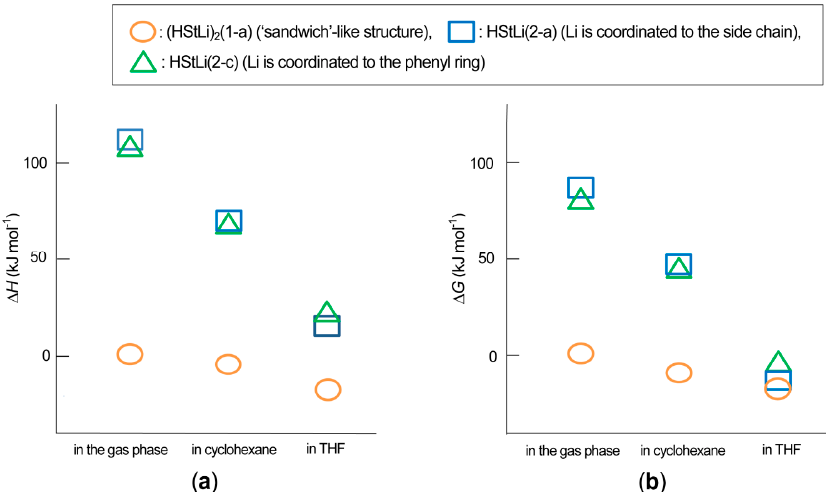
Figure 19. The effect of solvent environment on the enthalpies and free energies for (HStLi) 2 and HStLi structures shown in Figures 17 and 18. ∆ H and ∆ G were calculated with respect to 1/2[(HStLi) 2 (1-a)] in the gas phase, for which ∆ H = 0 ( a ) or ∆ G = 0 ( b ).